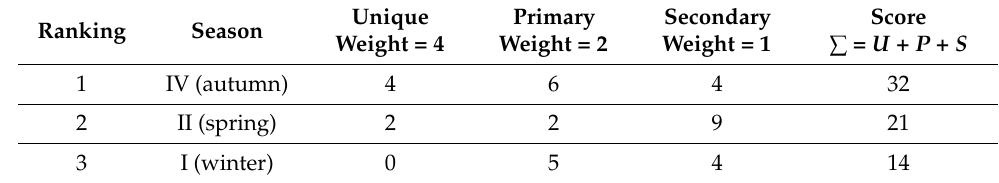
Table 7. Ranking of usefulness of multispectral data according to the acquisition times (seasons).